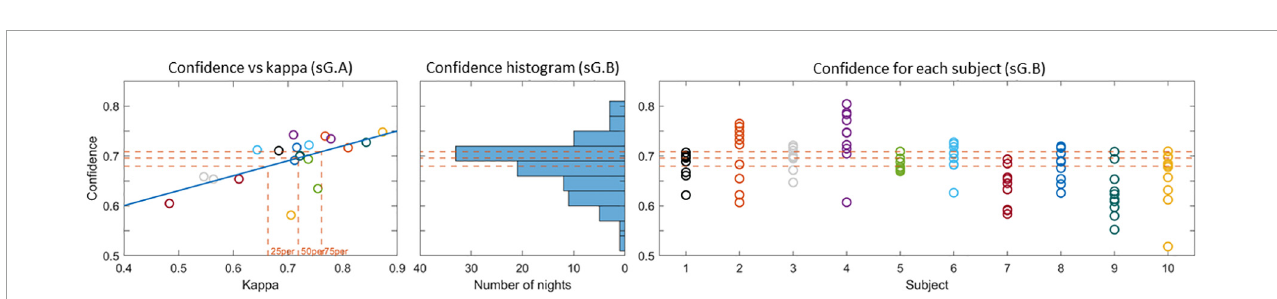
FIGURE7 (Left) Confidence versus kappa value for the sG.A recordings. The 25th, 50th, and 75th percentiles of the kappa values and the corresponding confidences are shown with dashed lines. (Center) Histogram of the confidence values for the sG.B recordings. (Right) Confidence values for each recording. The 25th, 50th, and 75th percentile confidence values are presented with dashed lines in all